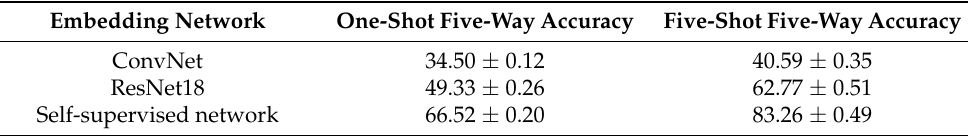
Table 8. Analysis of several embedding networks’ effects on one-shot five-way vs. five-shot five-way task accuracy (%). Ninety-five percent confidence intervals are given for all results.